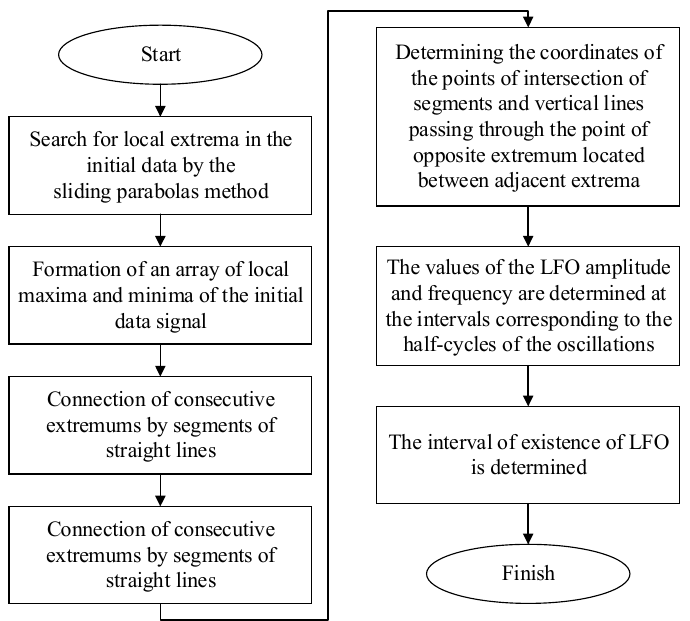
Figure 4. Flow chart of the proposed method of LFO analysis.